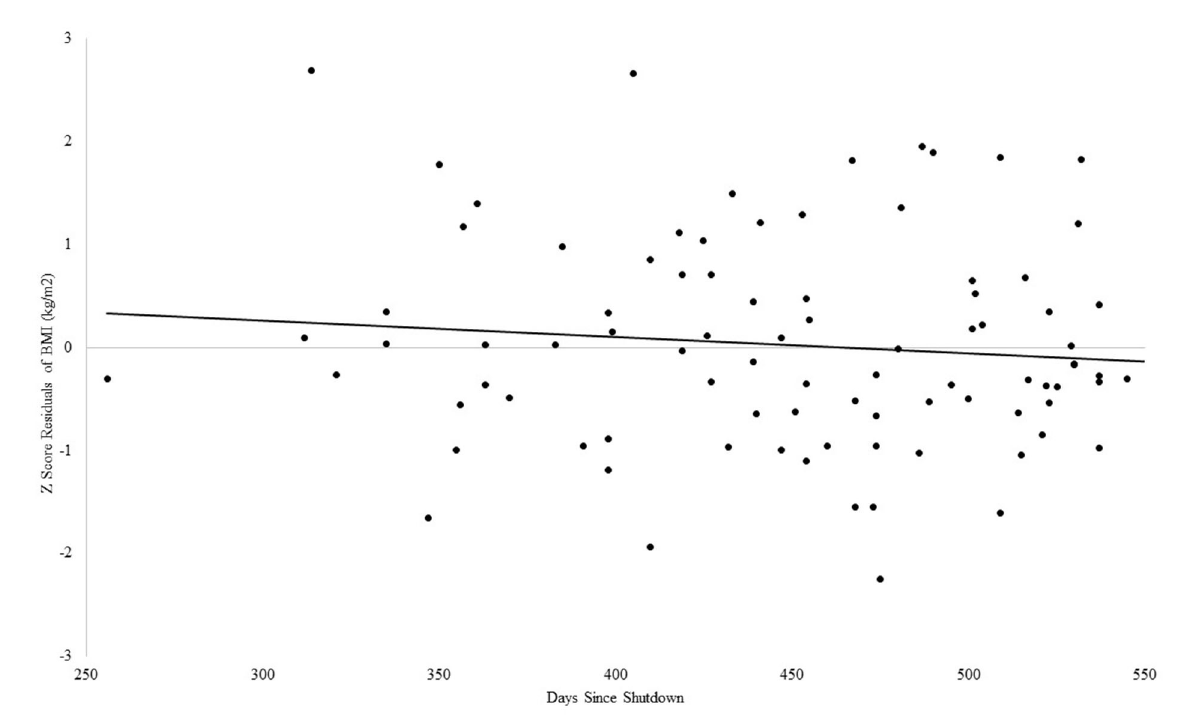
FIGURE5 Association between days since COVID-19 shutdown and BMI in older adults.